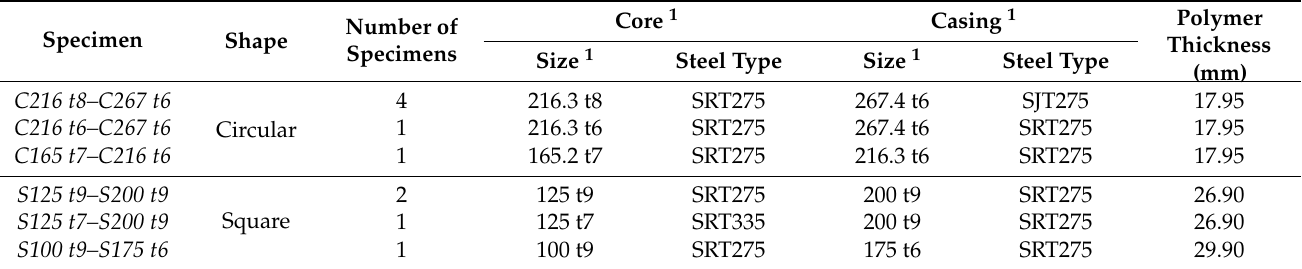
Table 1. Test specimens.